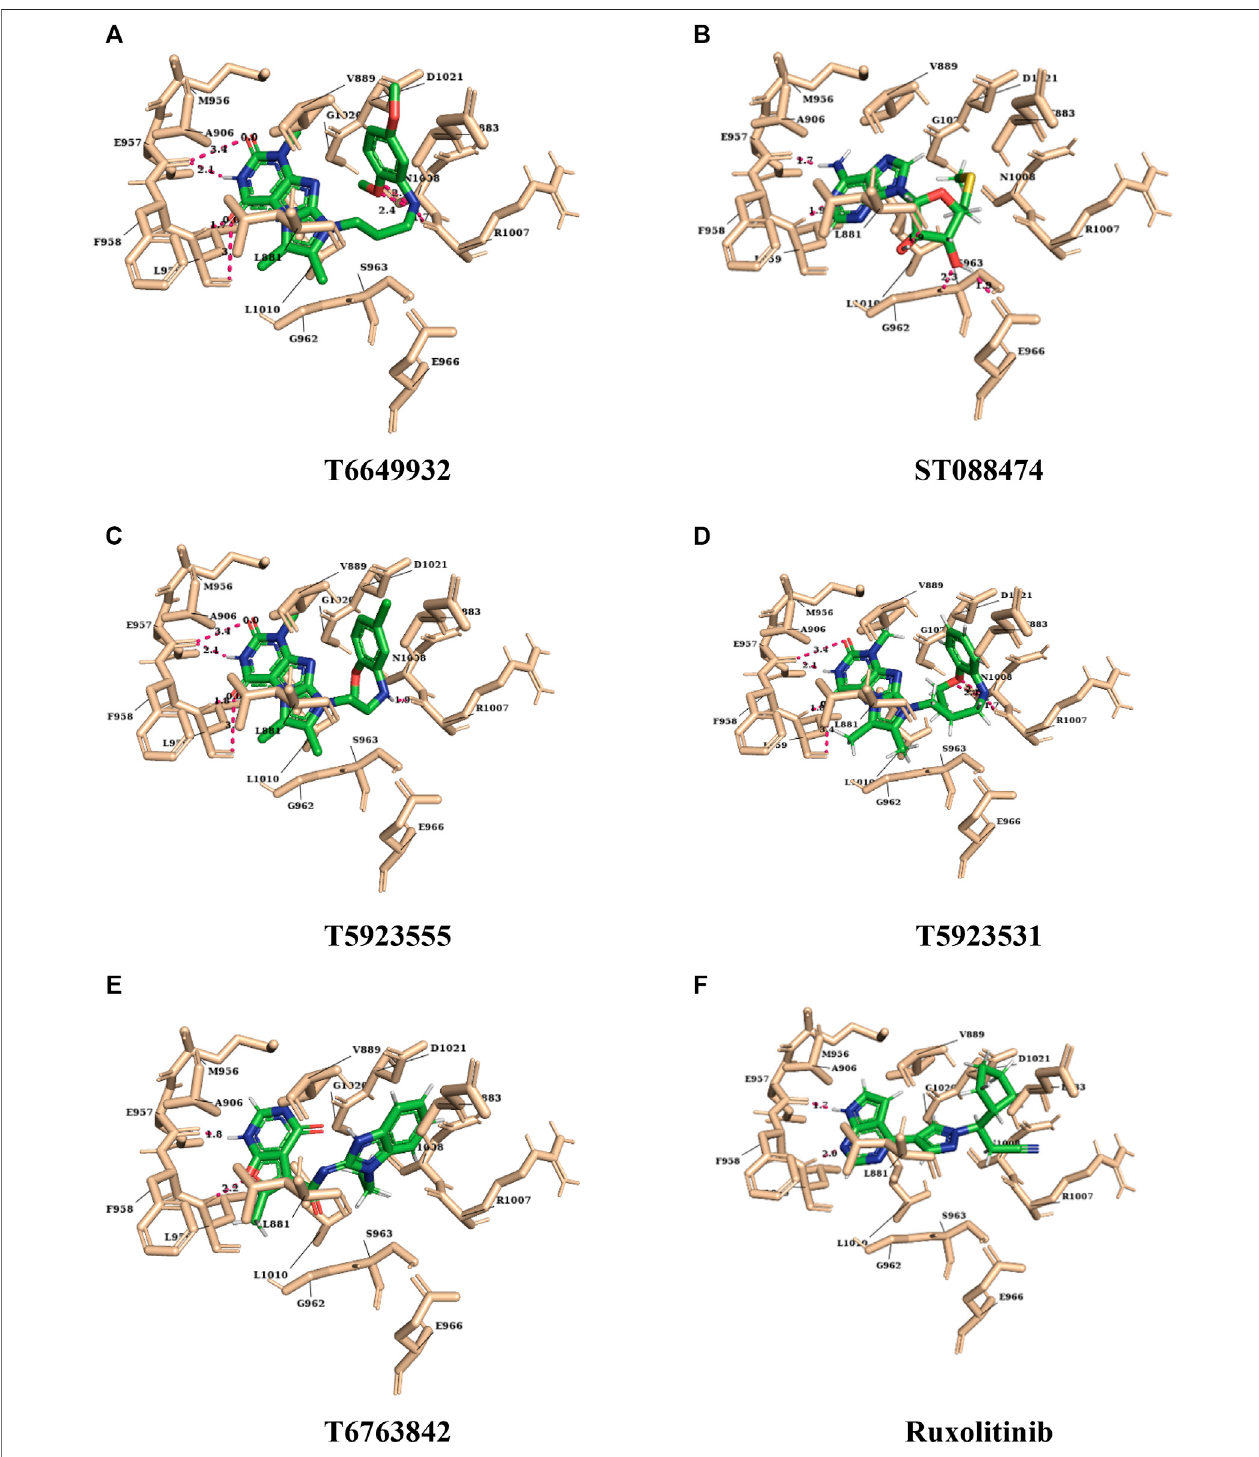
FIGURE 4 | The representation of docked lead compounds and drug ( (A) T6649932, (B) ST088474, (C) T5923555, (D) T5923531, (E) T6763842, and (F) ruxolitinib) present inside the ATP-binding site of JAK1 after molecular docking.